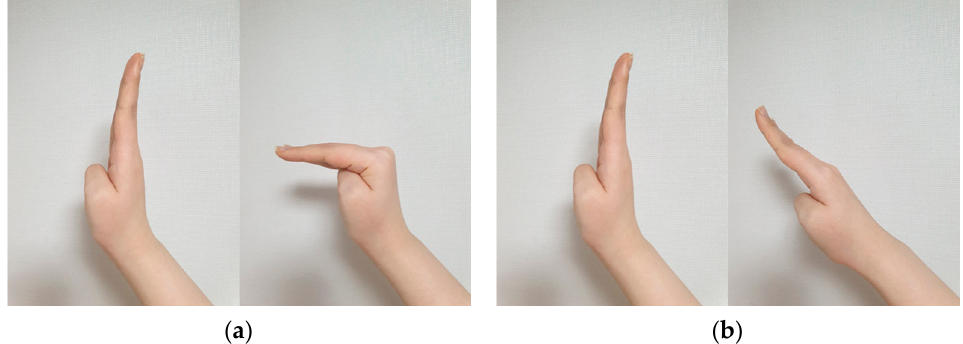
Figure 4. Cases that the tip joint greatly change: ( a ) case of right angle; ( b ) case of diagonal.